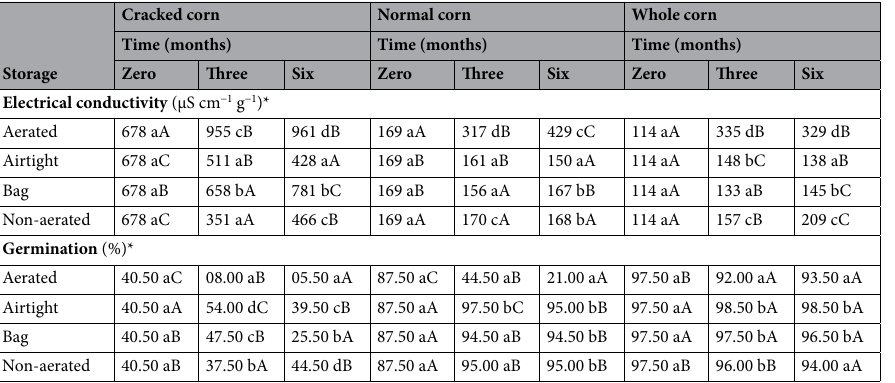
Table 3. Physical quality of corn stored under different systems and durations. *Means followed by the capital letter in the line for each storage time and lowercase in the column for each storage form, do not differ at 5%